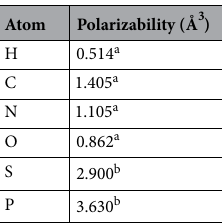
a Values from Ref. 36 , (cid:31) = 589.3 nm.